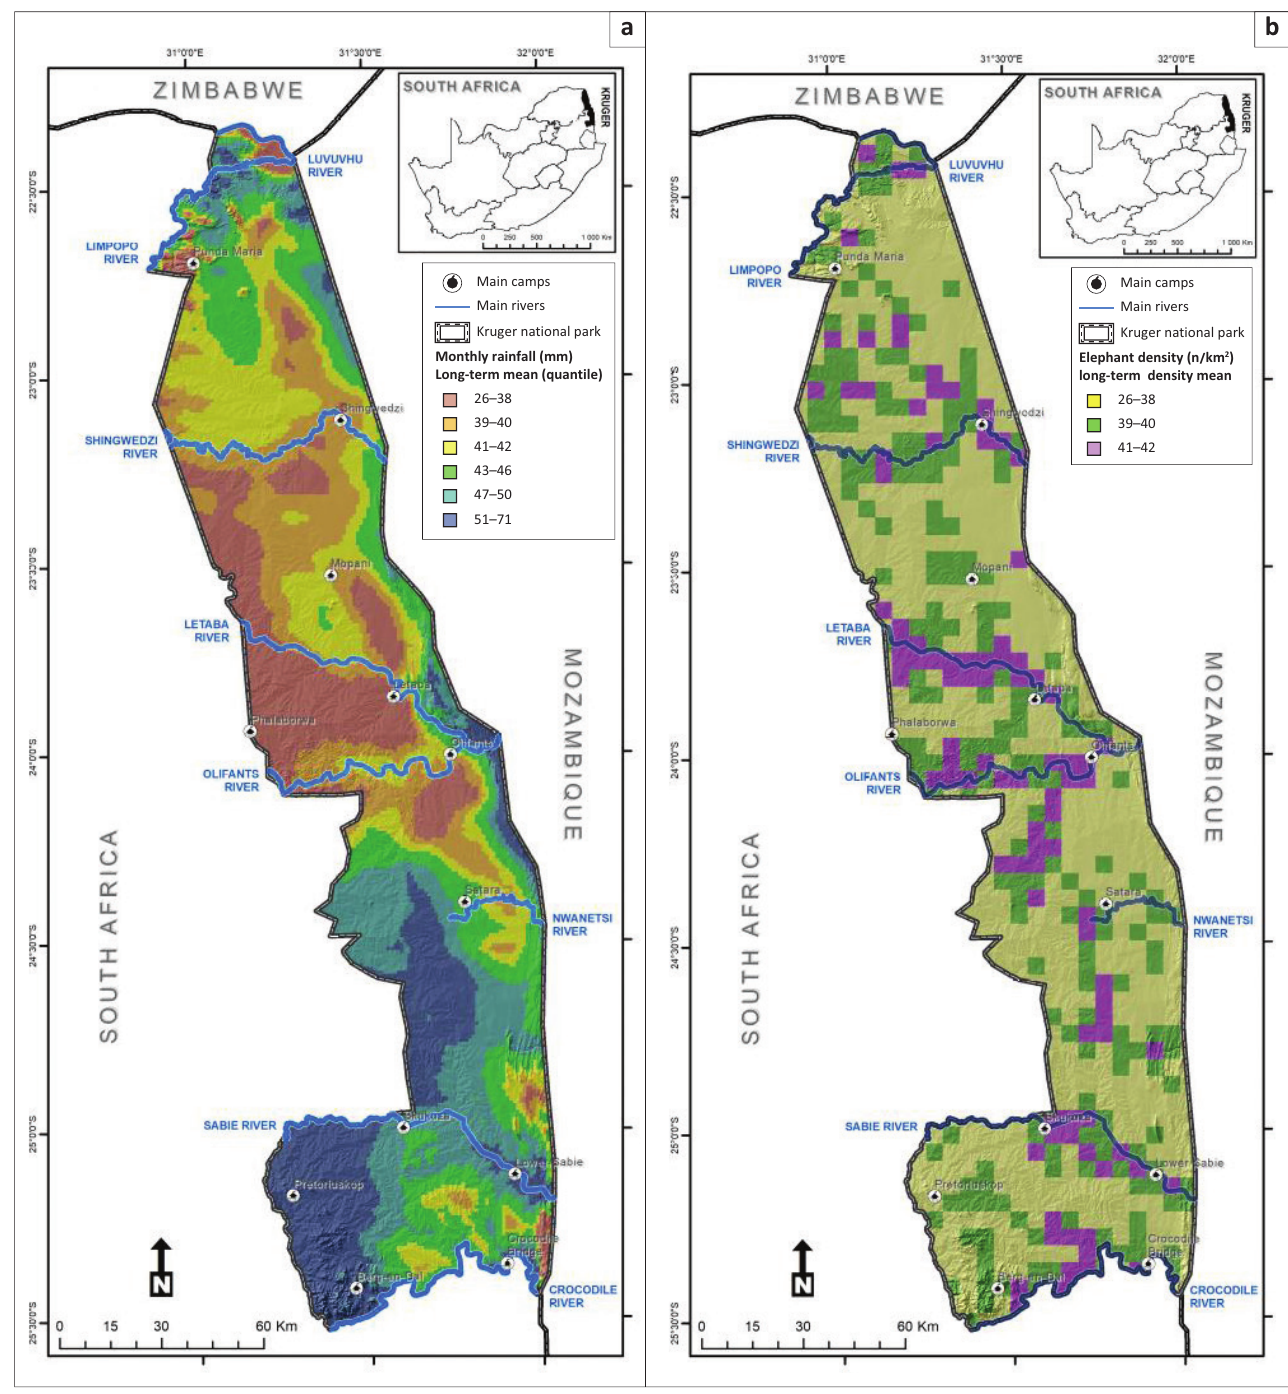
FIGURE 1: (a) The Kruger National Park, South Africa, lies between latitudes 22°19’40” S to 25°31’44” S and longitudes 30°53’18” E to 32°01’59” E. Main rivers (in blue) supply water throughout the year. Rainfall occurs mainly in summer and varies in the park. The long-term average monthly rainfall for areas is indicated in the figure by a colour sequence from red (dry) to blue (wet). (b) Average elephant density observed in each 25 km 2 grid-cell throughout the study period (1985–2012). Grid-cell colour indicates density of elephants per square kilometre. High density cells are coloured in purple, whilst medium and low-density cells are in green and yellow. The data are from yearly elephant